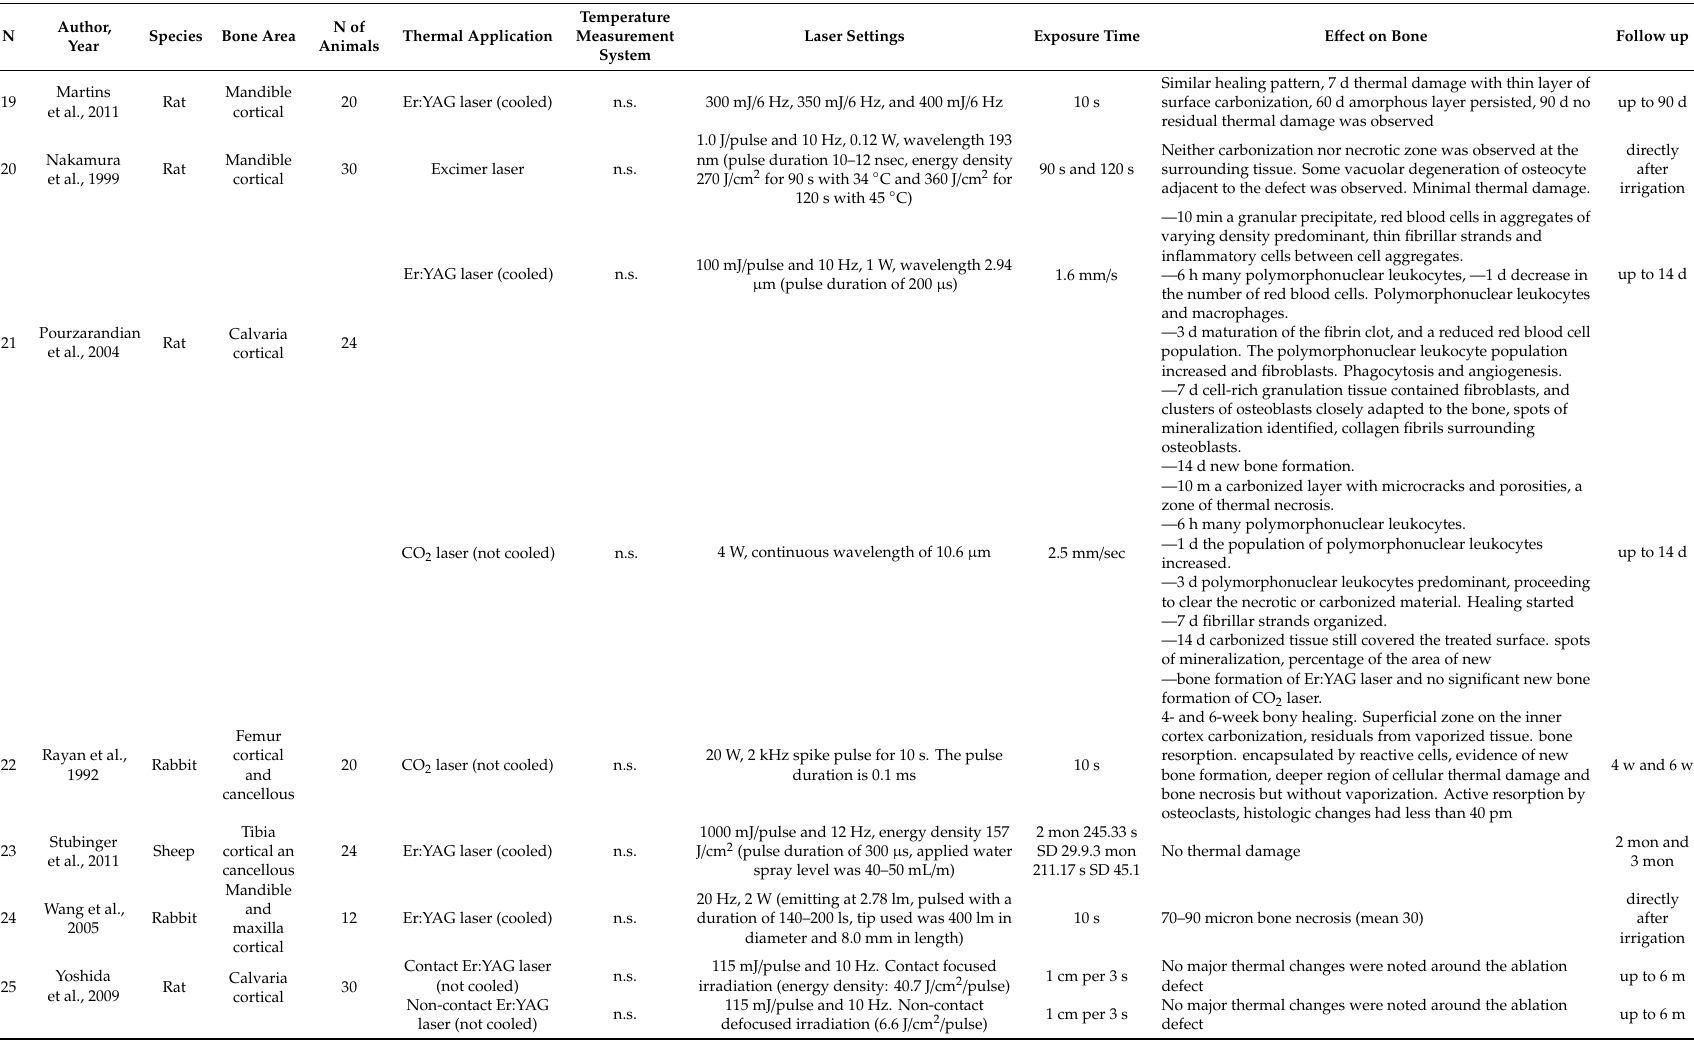
Table 4. Included animal studies evaluating laser parameters on bone damage (n.s. = not specified, s = seconds, m = minutes, h = hours, d = days, w = weeks, and mon =